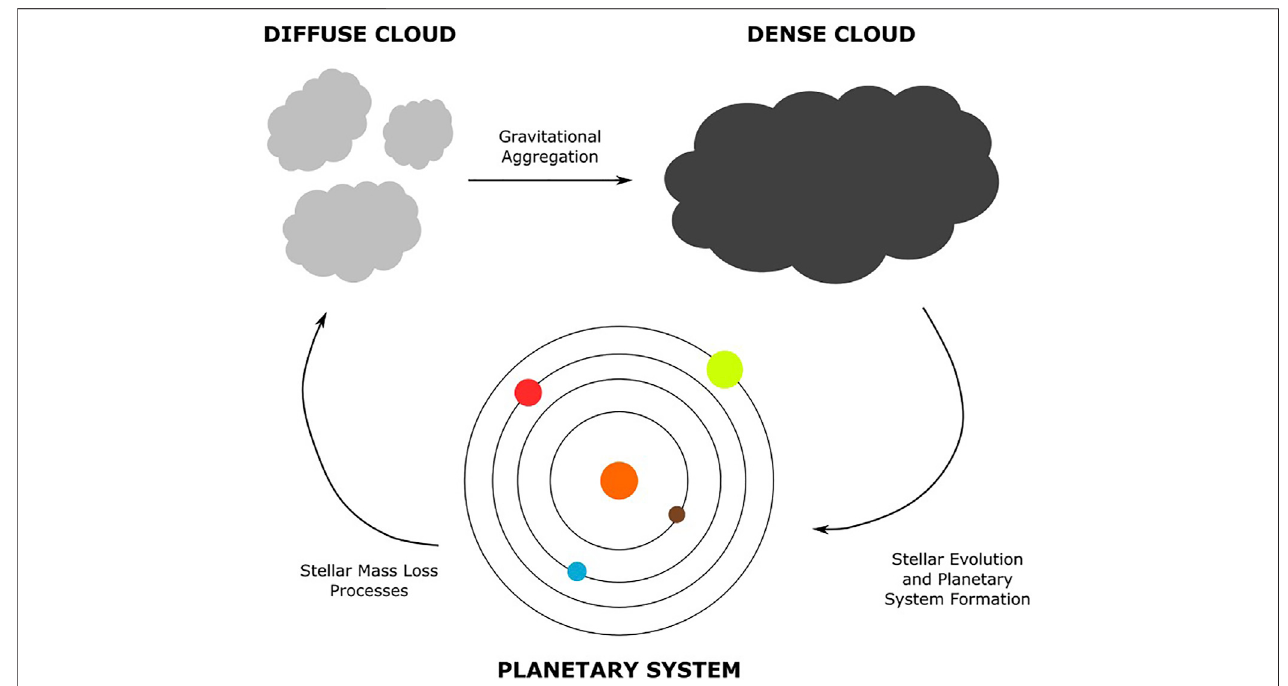
FIGURE1| Matterinthe interstellar medium iscycledthrough various phases: theaggregation ofmatterresultsin optically transparent diffuseclouds evolving into dense, dark molecular clouds. These clouds are considered to be “ stellar nurseries ” in which localized gravitational collapse results in the formation of a proto-star, with further accretion of material occurring via magneto-hydrodynamic fl ows onto the growing star. Within a few million years, the stellar object evolves into a pre-main sequence star surrounded by a proto-planetary disk. Collisions within the disk result in the accretion of dust grains which slowly grow to form planetesimals, thus taking the fi rst steps towards the formation of a planetary system. Once the star ’ s nuclear fuel has been exhausted, it may follow one of two routes depending on the stellar mass: low-mass stars undergo several mass-loss processes in which molecular material is dispersed back into the interstellar medium leaving behind a remnant white dwarf, whereas high-mass stars instead explode as supernovae with their cores eventually becoming either neutron stars or black holes.